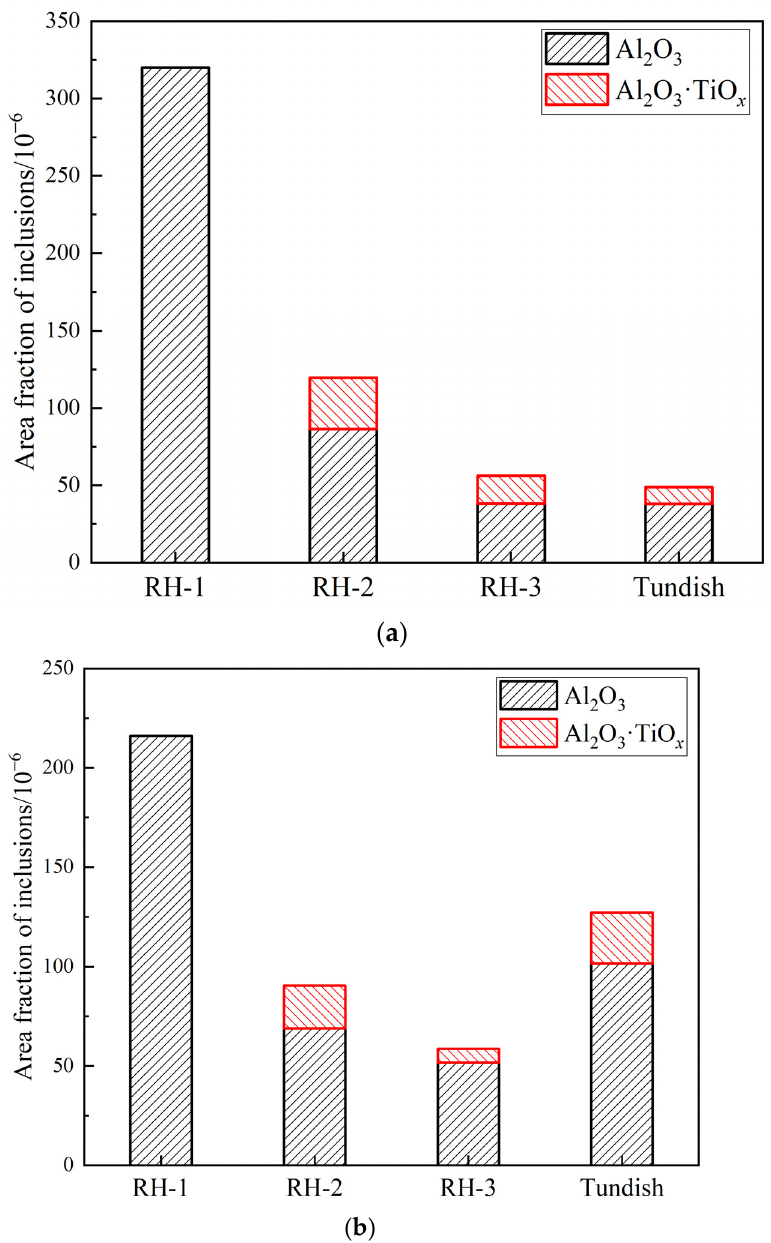
Figure 3. Change of the area fraction of inclusions in ( a ) Heat 1 and ( b ) Heat 2 during RH treatment and tundish processes